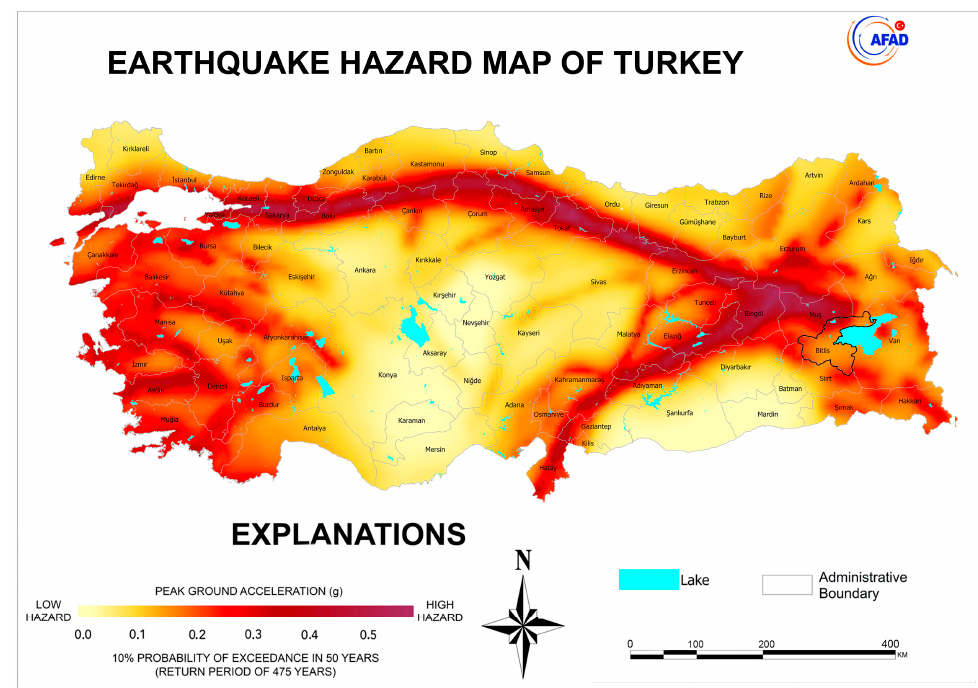
Figure 5. The current Earthquake Hazard Map of Türkiye [18].